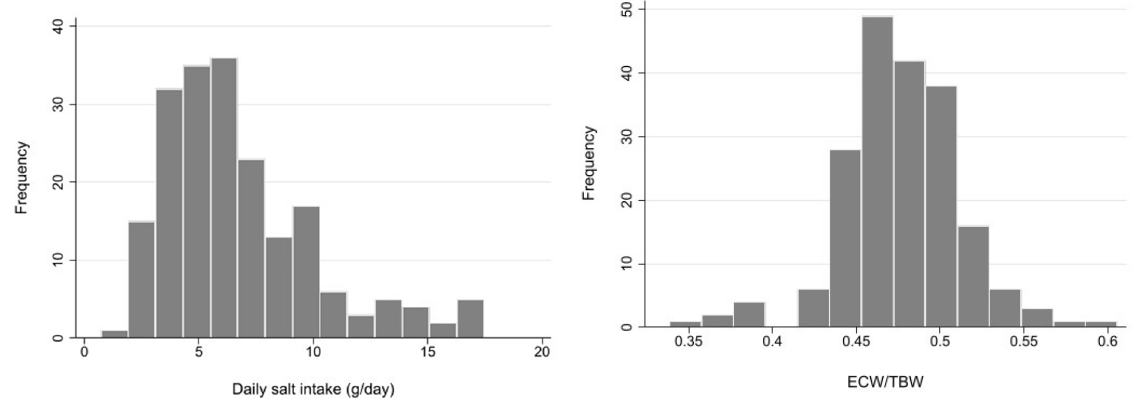
Figure 1. Histogram of daily salt intake and extracellular water (ECW)/total body water (TBW). ECW: extracellular water, TBW: total body water. Table 1. Baseline characteristics.